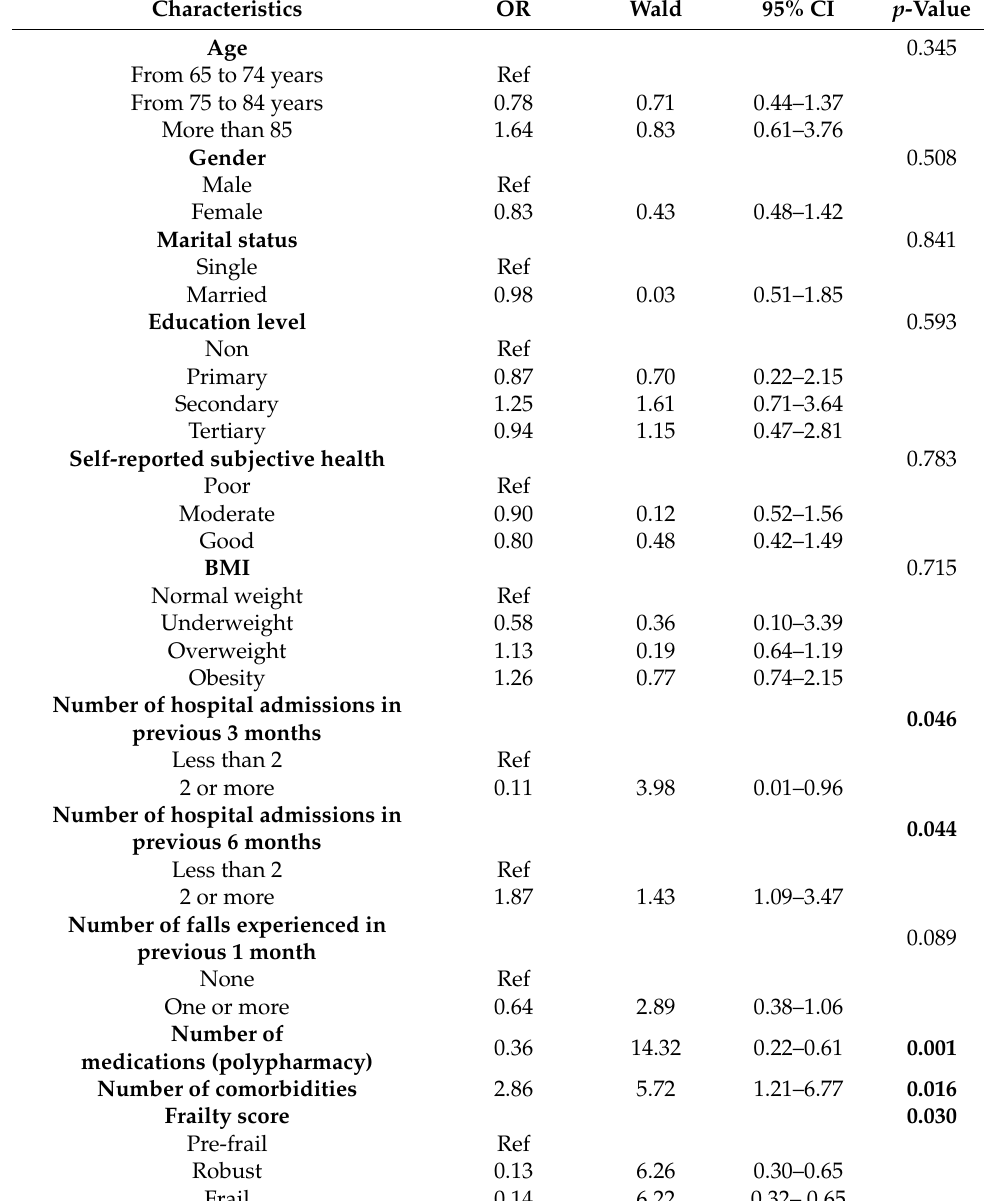
Table 2. Association between demographic factors and potentially inappropriate medication use using logistic regression